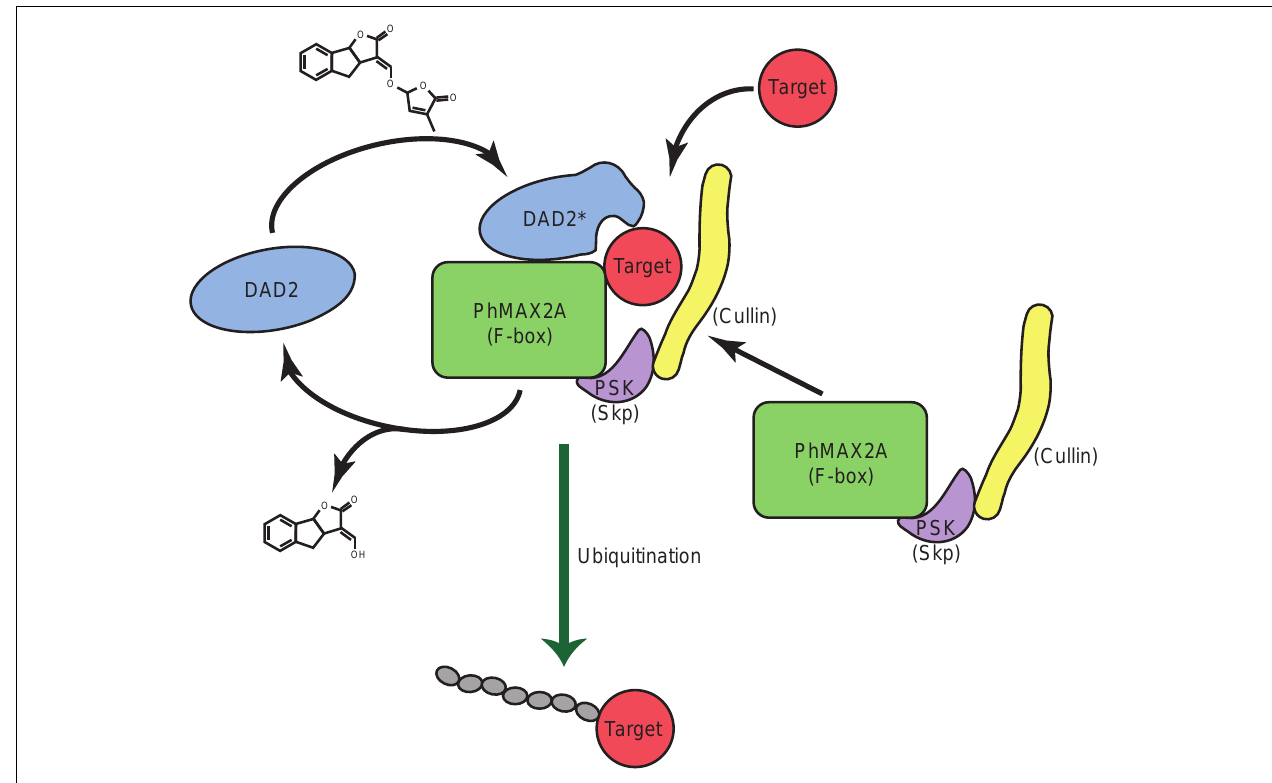
the SCF MAX2 complex.Target protein(s) are recognized by the DAD2- SCF MAX2 complex and ubiquitinated. DAD2* hydrolyses SL, releasing